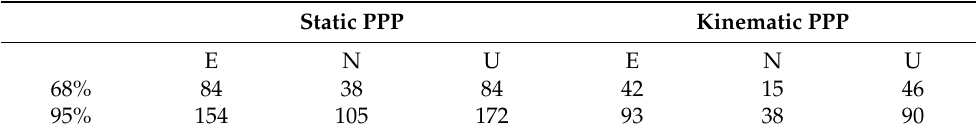
Table 16. Convergence time of the QF method (unit: min) (R/B/E). Static PPP Kinematic PPP